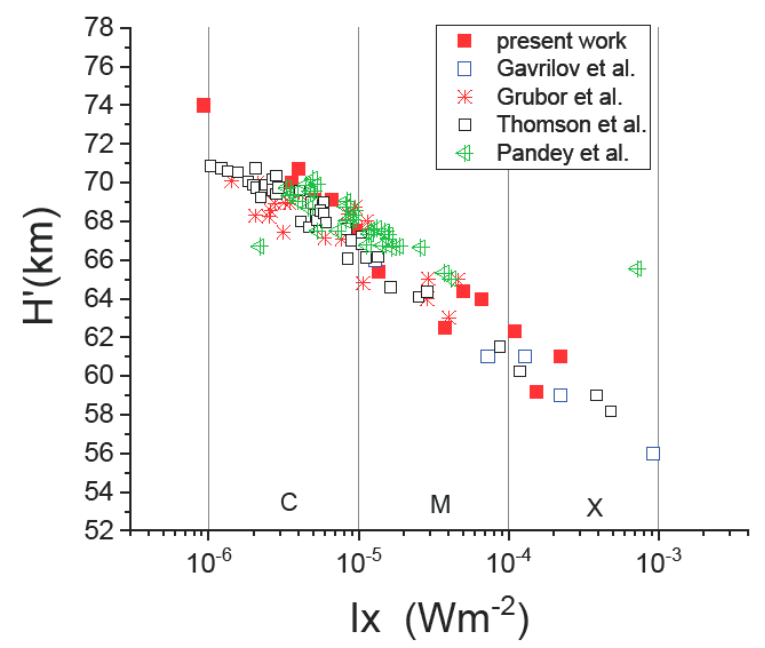
Figure 12. The effective reflection height (red squares) calculated for this study is plotted together with the results of other authors [41–44].